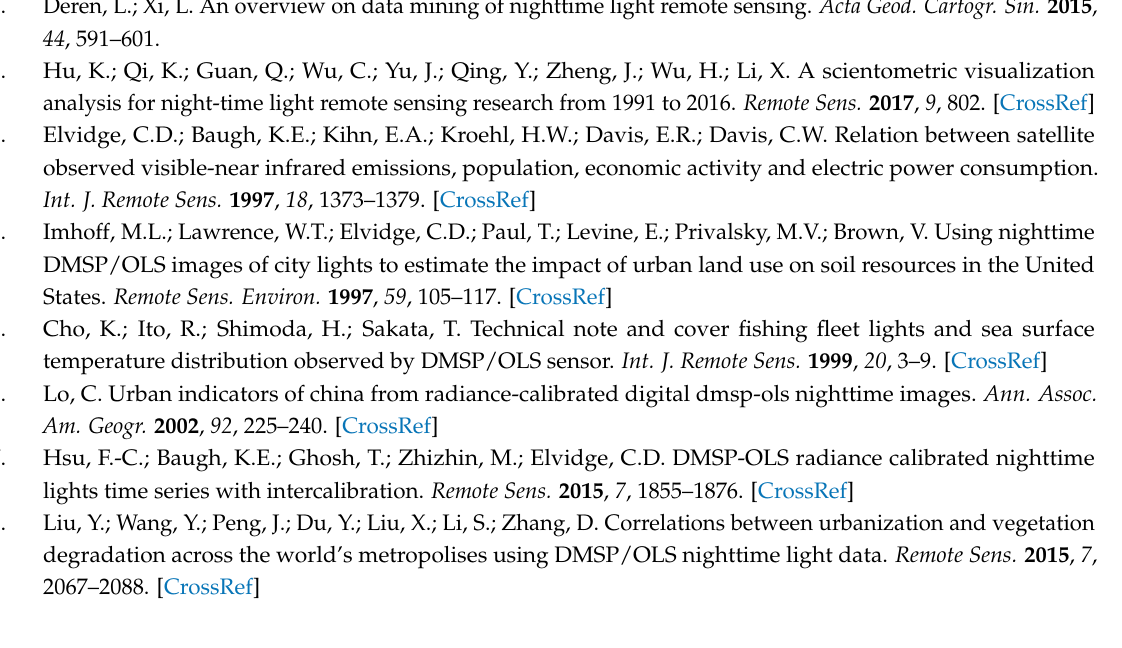
Figure 16. Images of Amsterdam (52 ◦ N), in different seasons. ( a ) Acquired on 29 June 2018; ( b ) acquired on 7 September 2018.